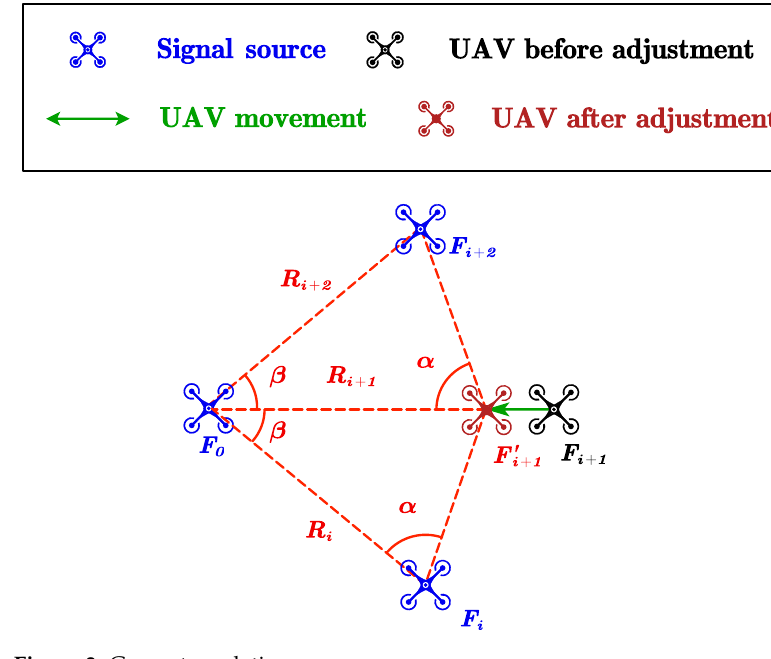
Figure 3. Geometry